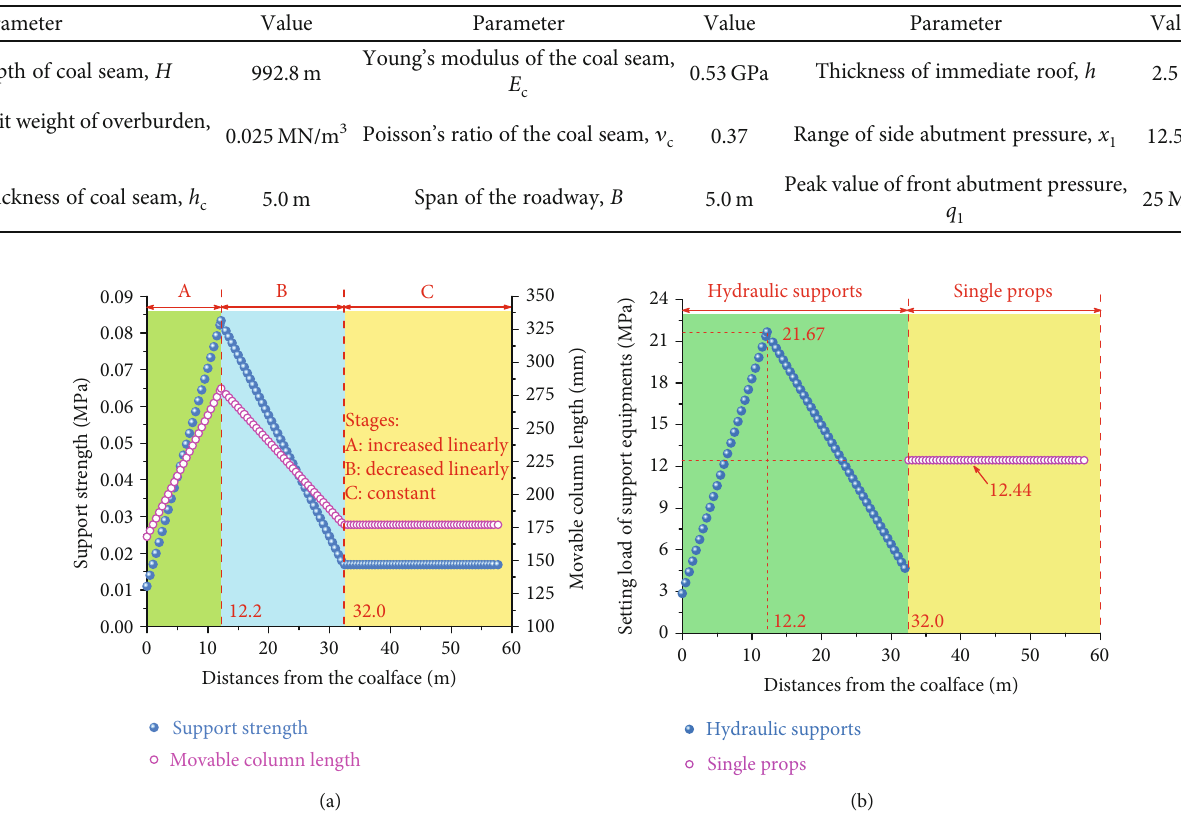
Figure 10: Support parameters in roadway of the 5306 coalface: (a) support strength and roof settlement; (b) setting load of